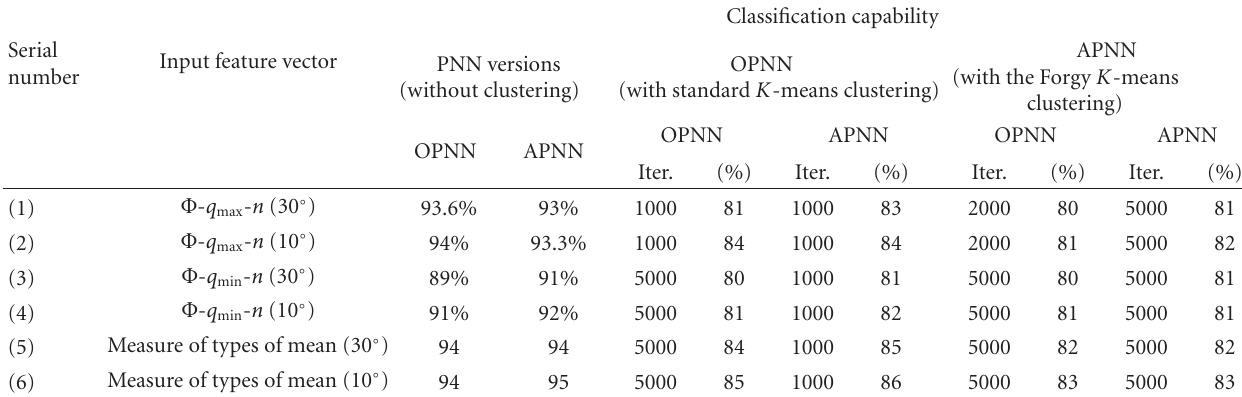
Table 7: Comparison of classification capability of OPNN and APNN with versions of K -means clustering